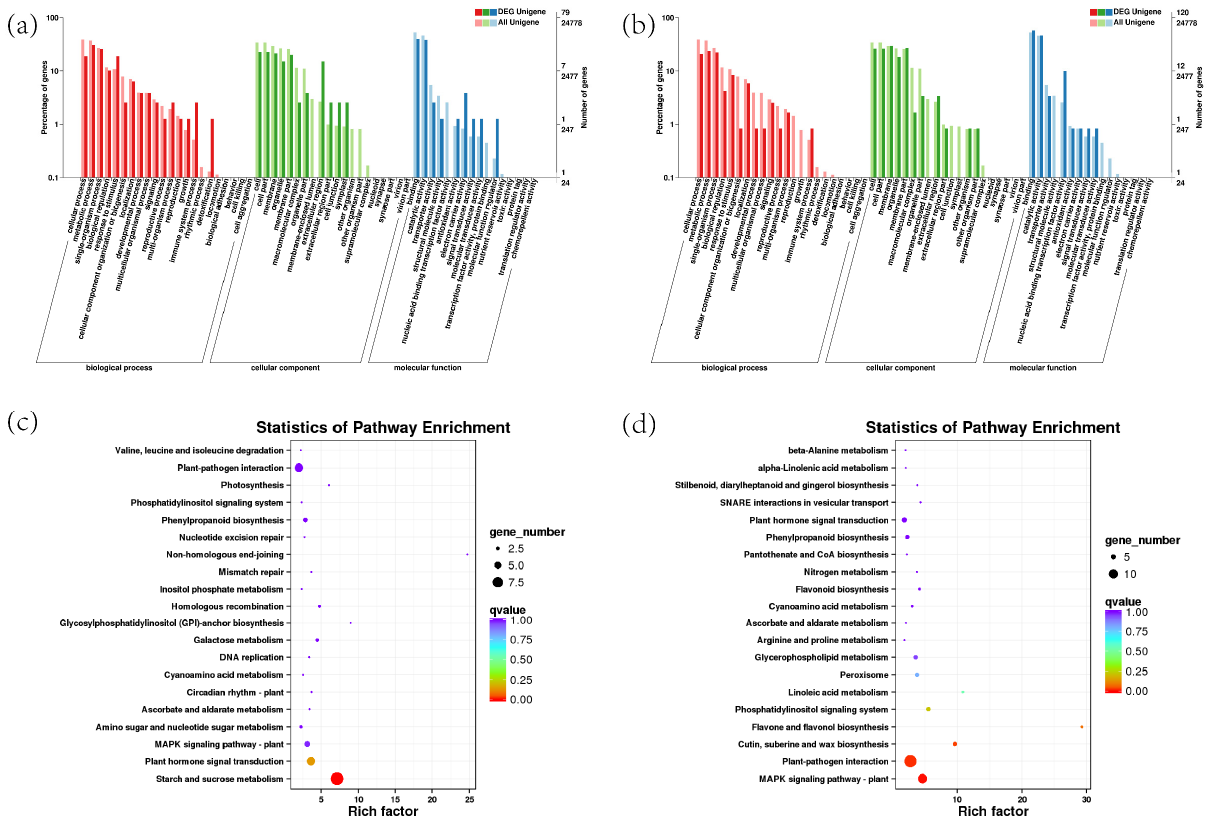
Figure 13. GO and KEGG enrichment analyses for the DEGs. ( a , b ) GO analysis of up-regulated and down-regulated DEGs; ( c , d ) KEGG analysis of up-regulated and down-regulated DEGs; significant enrichment was assumed for GO enrichment terms and KEGG enrichment terms, with a p -value of 0.05.